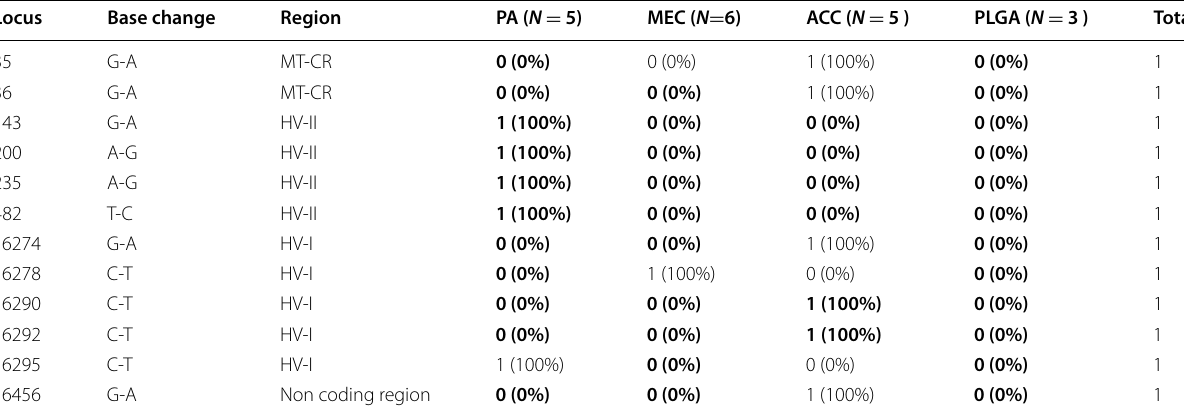
Table 2 Uncommon D-loop variations among the groups